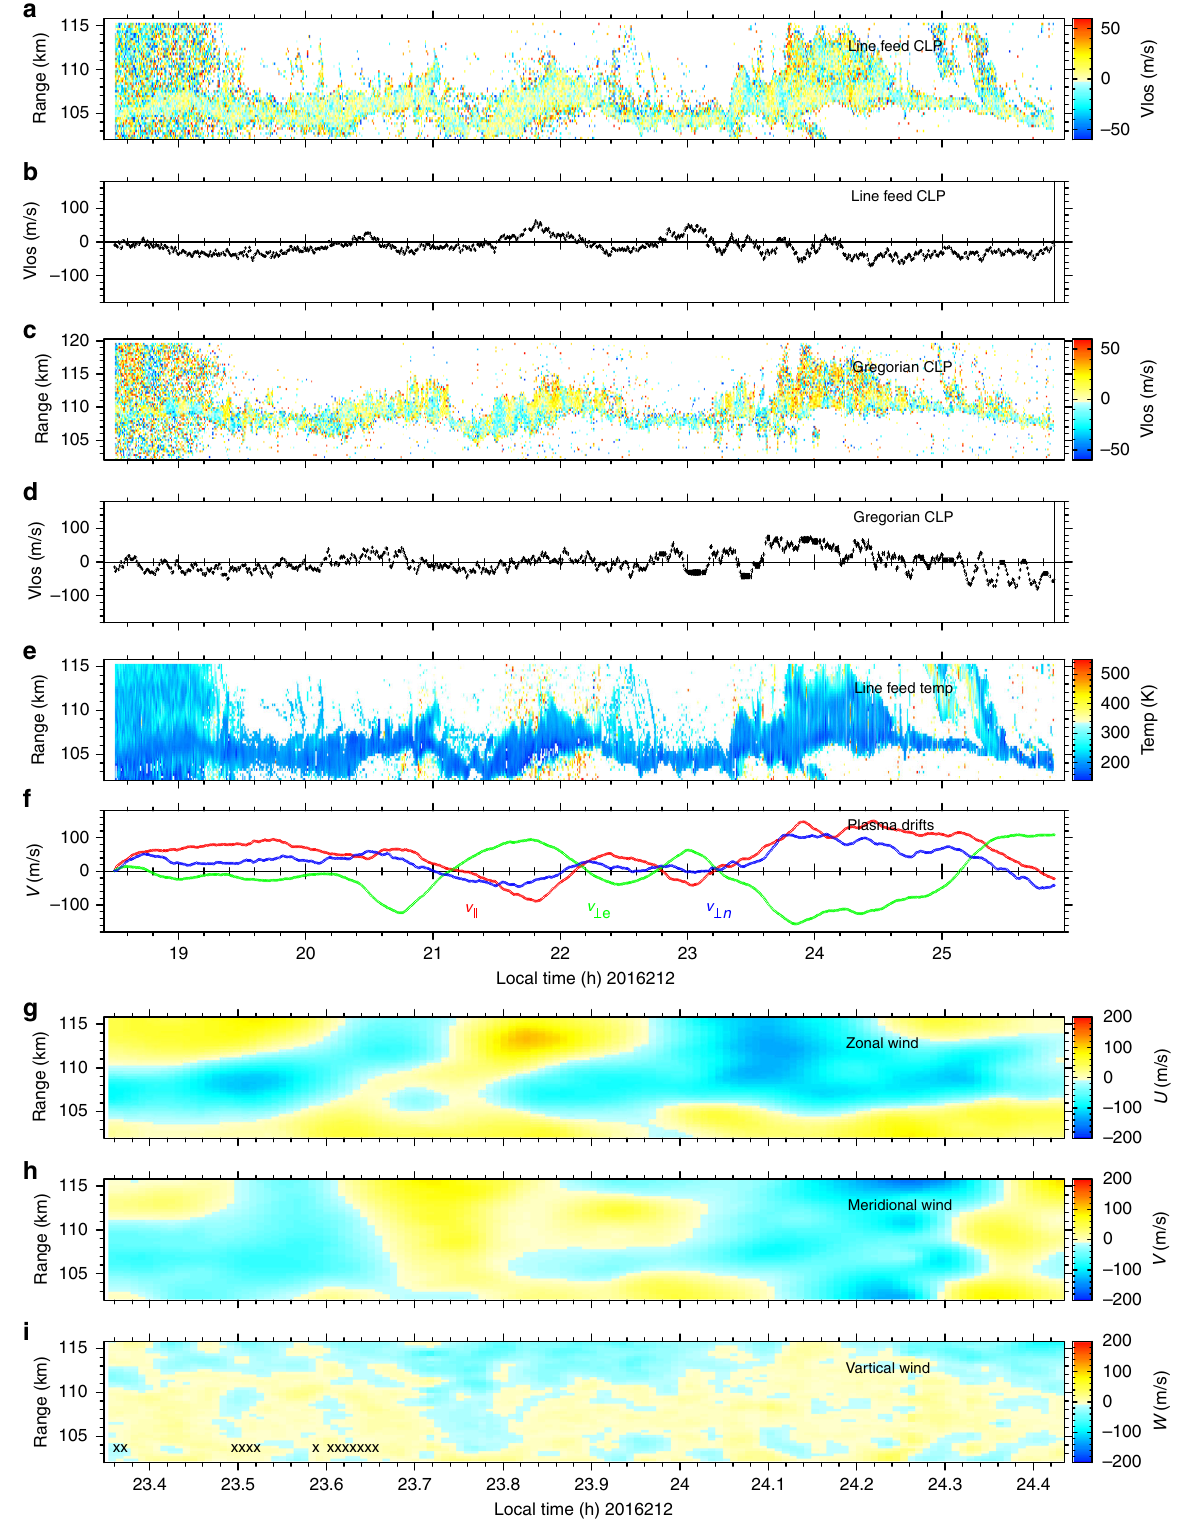
Fig. 3 State parameters derived from incoherent scatter measurements using dual radar beams. a Line-of-sight E -region plasma drift pro fi les measured at zenith. b Average line-of-sight F -region plasma drifts measured at zenith. c Line-of-sight E -region plasma drift pro fi les measured off zenith. d Average line- of-sight F -region plasma drifts measured off zenith. e E -region temperature pro fi les. f Average F -region vector plasma drifts. Here the red, green, and blue lines indicate drifts parallel to the geomagnetic fi eld, perpendicular and eastward, and perpendicular and upward/northward, respectively. g E -region zonal wind pro fi les. h E -region meridional wind pro fi les. i E -region vertical wind pro fi les. The bottom three panels re fl ect conditions within just the third patchy E